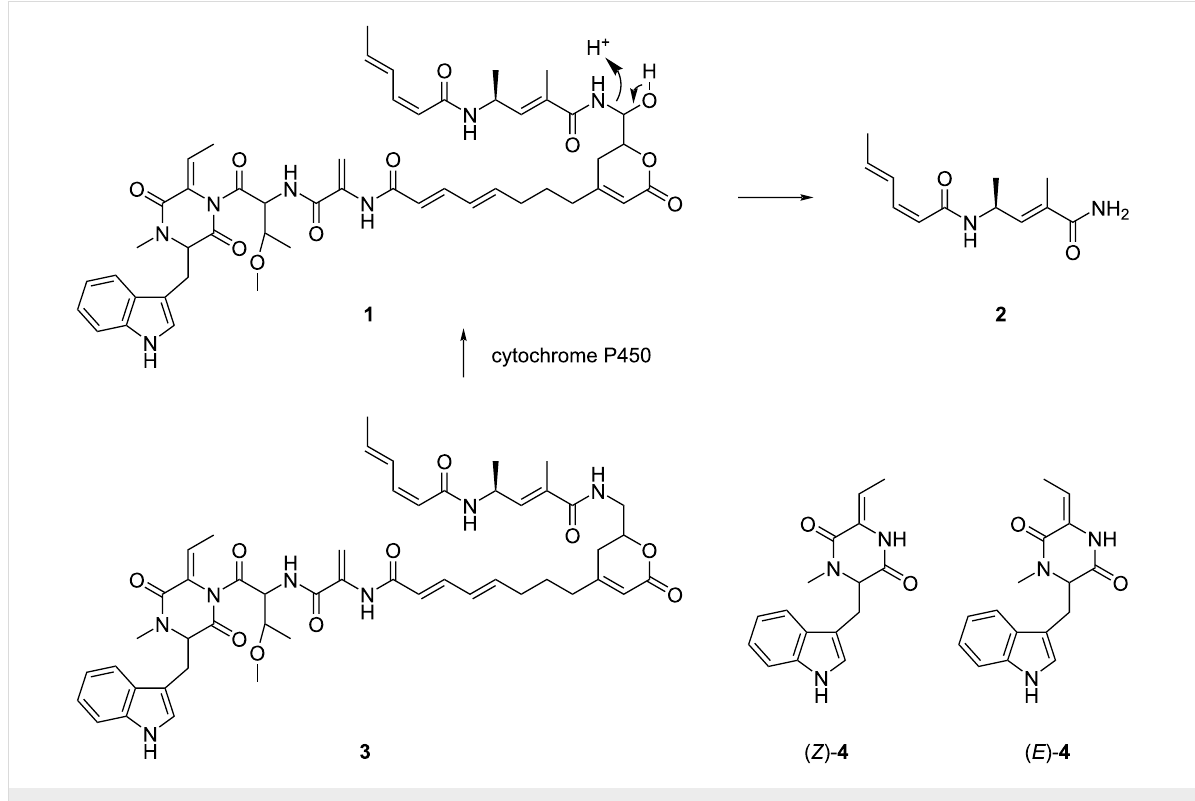
Scheme 1: Structures of hangtaimycin ( 1 ) and its